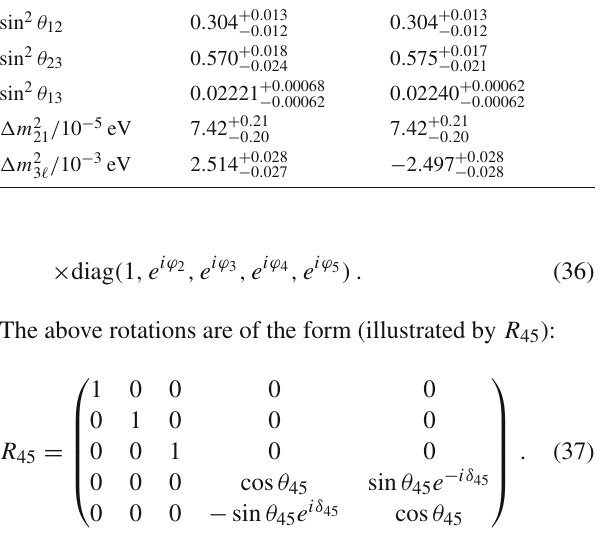
mixing parameters to their central values Normal